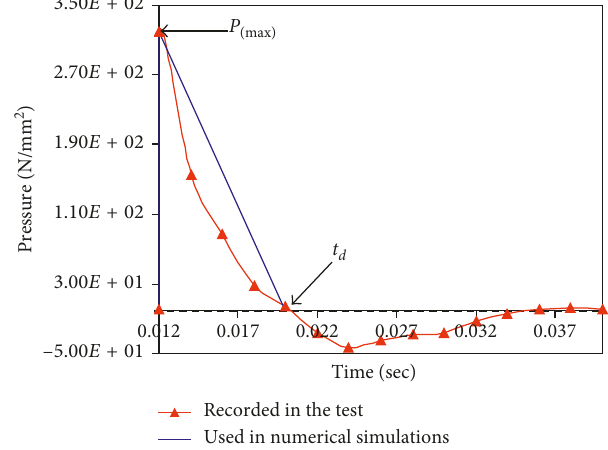
Figure 3: Comparison between the recorded [4] and simulated pressure-time history of the blast load.